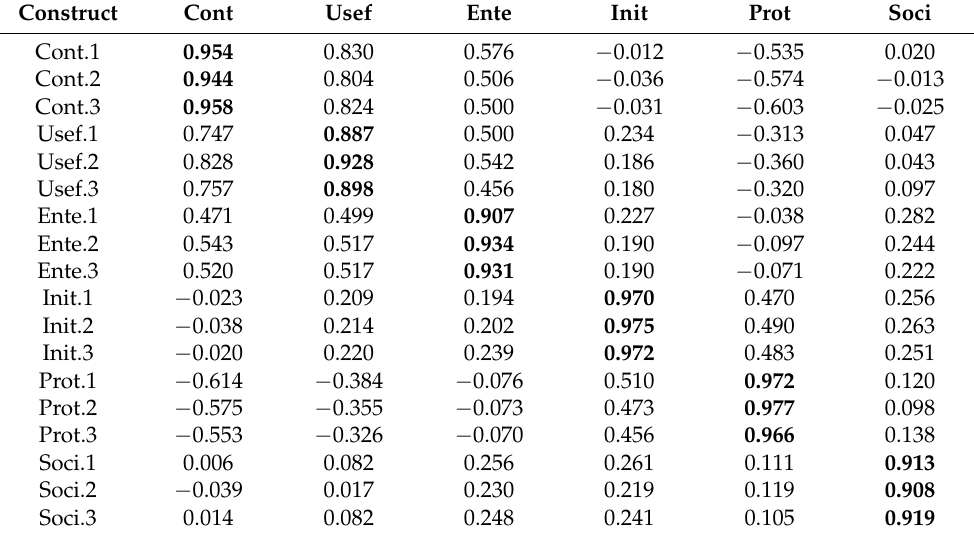
Table 5. Factor loadings and